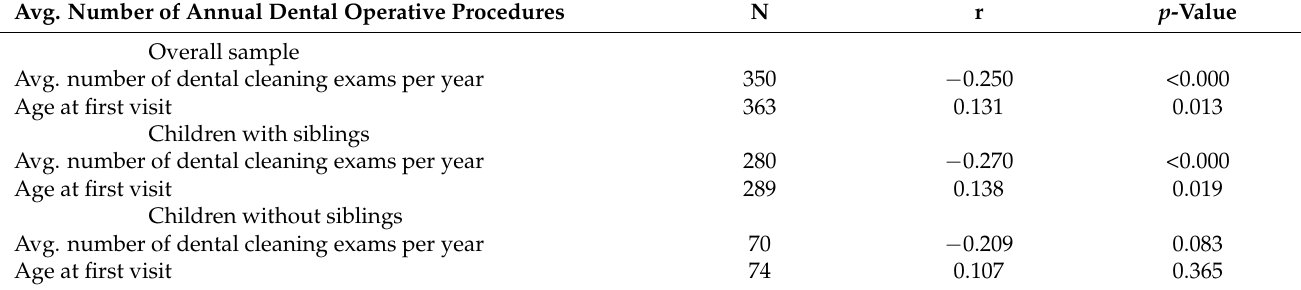
Table 2. Pearson correlation (r) between annual dental operative procedures and annual dental cleaning exams, age at first visit and children with and without siblings.